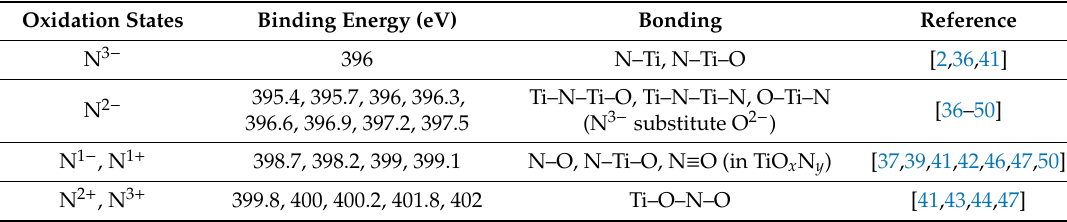
Table 2. Binding energies and types of bonding in the six N oxidation states. Oxidation States Binding Energy